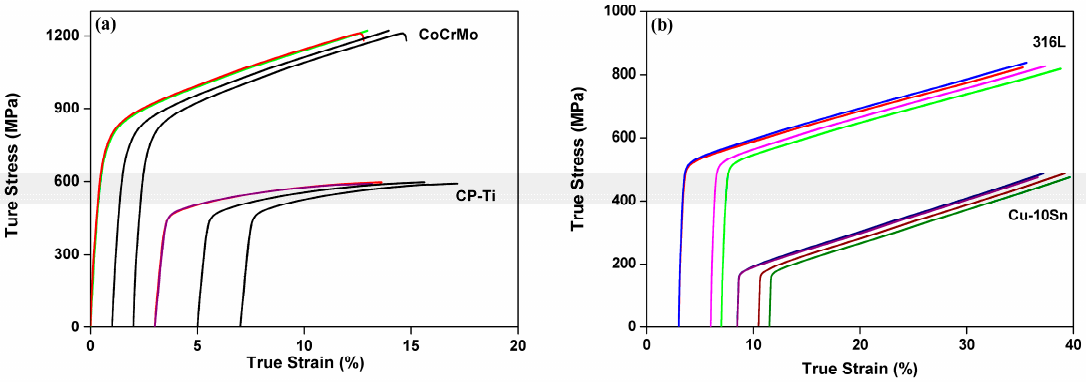
Figure 3. Room temperature tensile curves for ( a ) CoCrMo and commercially pure Ti (CP-Ti) and ( b ) 316L and Cu-10Sn bronze materials.